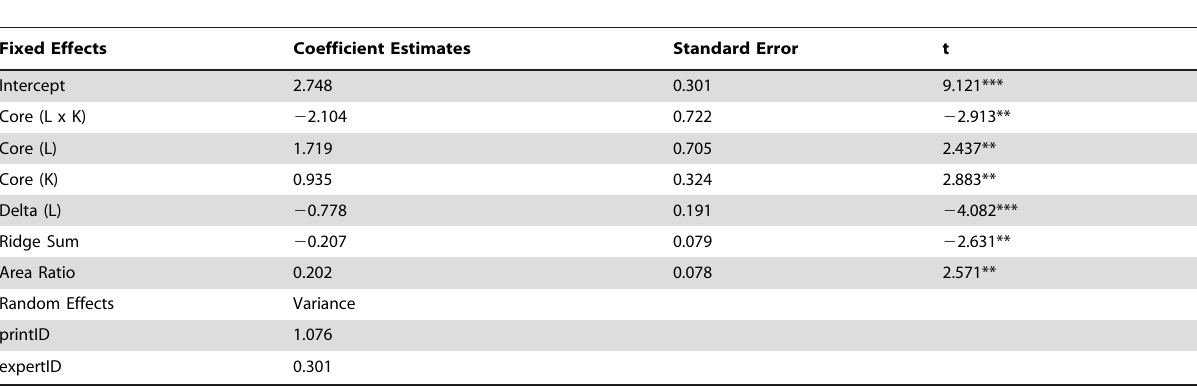
Table 4. Predictors for difficulty rating